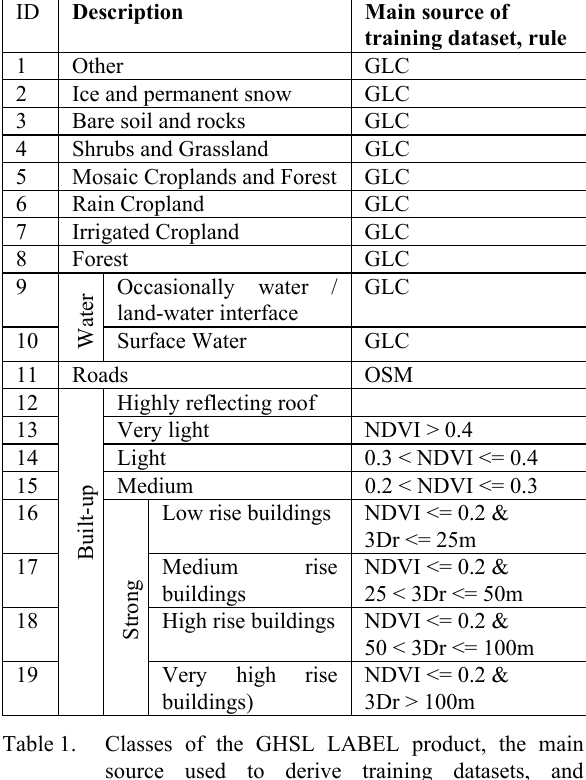
Classes of the GHSL LABEL product, the main source used to derive training datasets, and thresholds used in built-up area